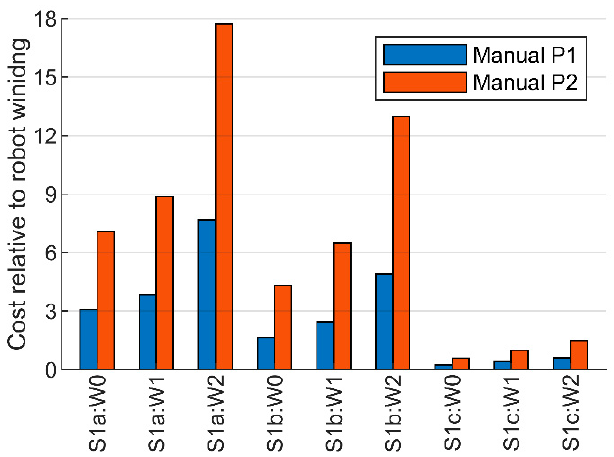
Figure 9. Estimated assembly costs for manual stator cable winding relative to robotized stator cable winding of S1a–c in winding development scenarios W0–2, for